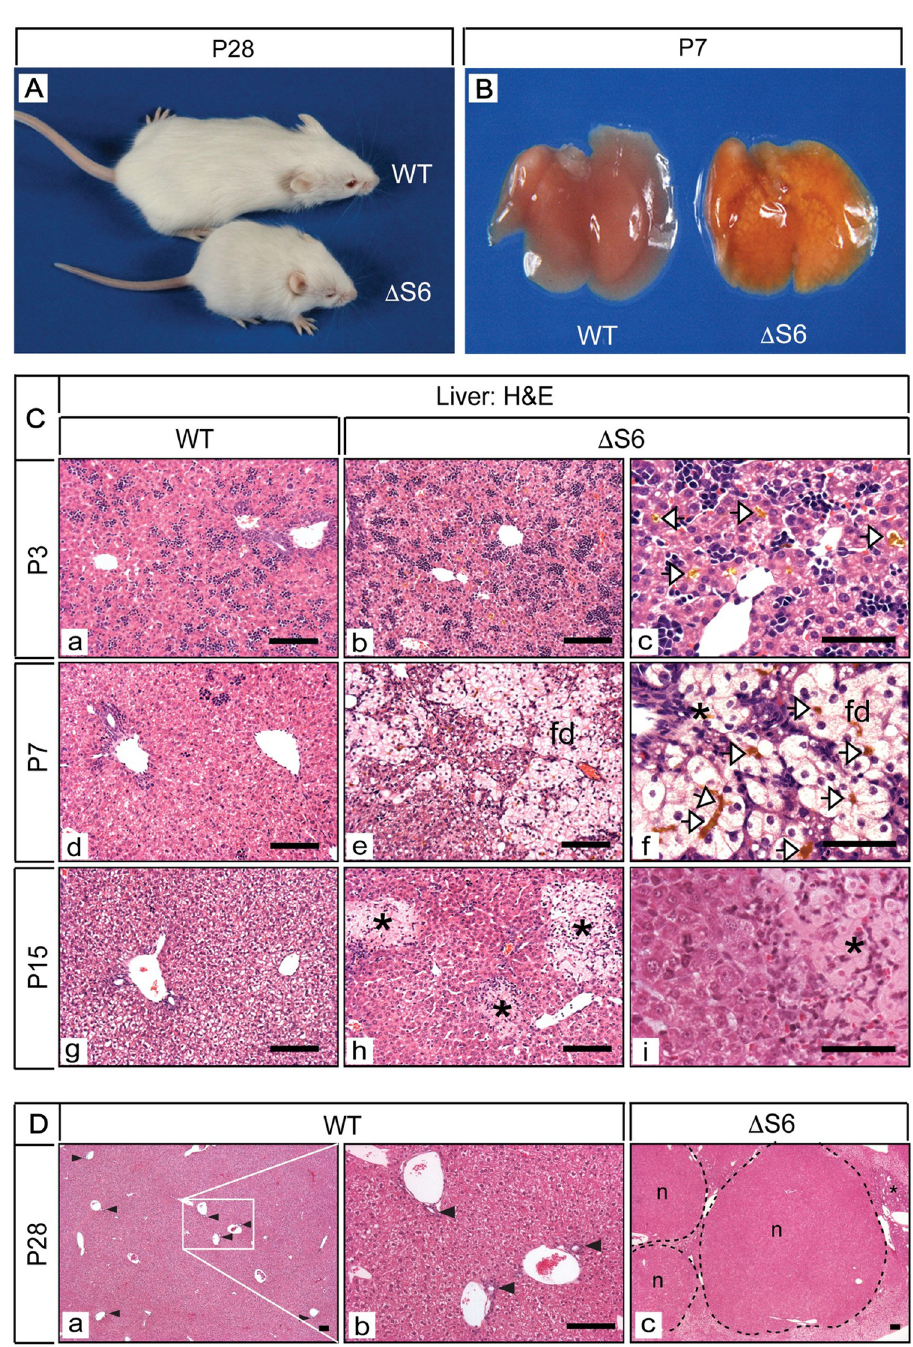
Fig 1. Perinatal deletion of hepatic Rps6 retards growth and results in cholestatic liver disease. (A) A WT and runted Δ S6 mouse at postnatal day 28 showing that hepatic Rps6 - deficiency retards neonatal growth. (B) Gross appearance of livers from a WT and a Δ S6 mouse at post-natal day 7 (P7). Severe yellowing of the Δ S6 liver is indicative of cholestatic disease. (C) Photomicrographs of H&E stained sections of liver from WT mice at P3, P7 and P15 (a, d and g) and age-matched Δ S6 mice (b-i). Canalicular accumulation of bile (yellow deposits, open arrowheads) is evident in Δ S6 livers at P3 and P7 and feathery degeneration (fd) of hepatocytes is evident at P7. At P15, bile infarcts ( � ) resulting from bile leakage due to canalicular or hepatocyte membrane rupture can be seen throughout the parenchyma of Δ S6 livers (Original magnifications, a, b, d, e, g, h (x 125; 50 μ scale bars); c, f and i (x 375; 25 μ scale bars). (D) Photomicrographs of H&E stained sections of liver from a WT mouse (a and b) and a Δ S6 littermate (c) at 4 weeks of age. In contrast to the WT liver (a and b) which shows an abundance of bile ducts (arrowheads), Δ S6